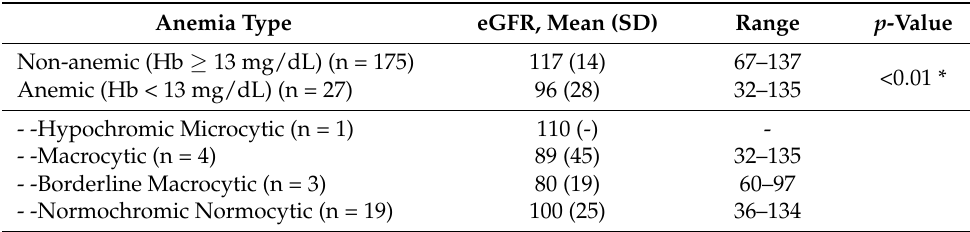
Table 8. Average eGFR by anemia